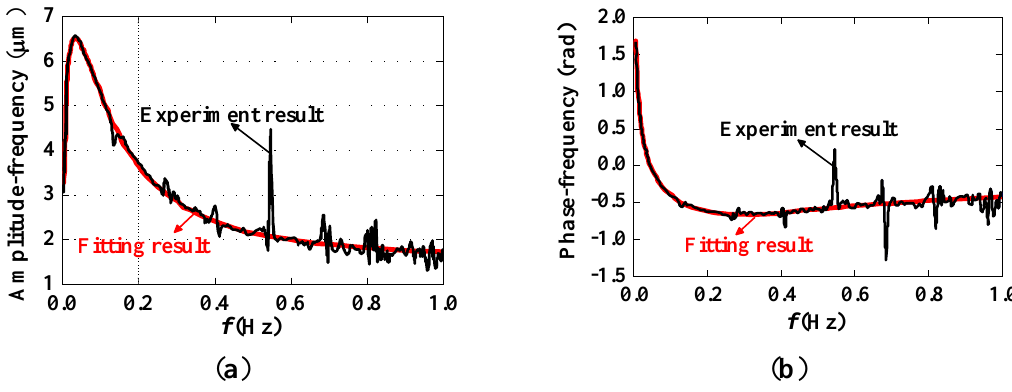
Figure 20. Frequency characteristics and fitting result. ( a ) Amplitude frequency response characteristic; ( b ) Phase frequency response characteristic.